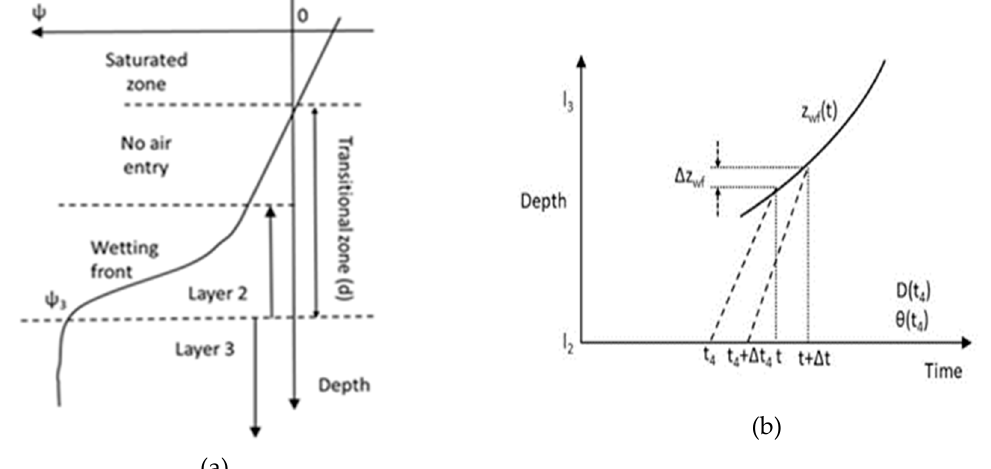
Figure 3. Figures showing two aspects of the modelling: ( a ) near-saturated zone between wetting front and saturation front, as described in Equation (26); and ( b ) changing speed of wetting front, as flux behind increases.